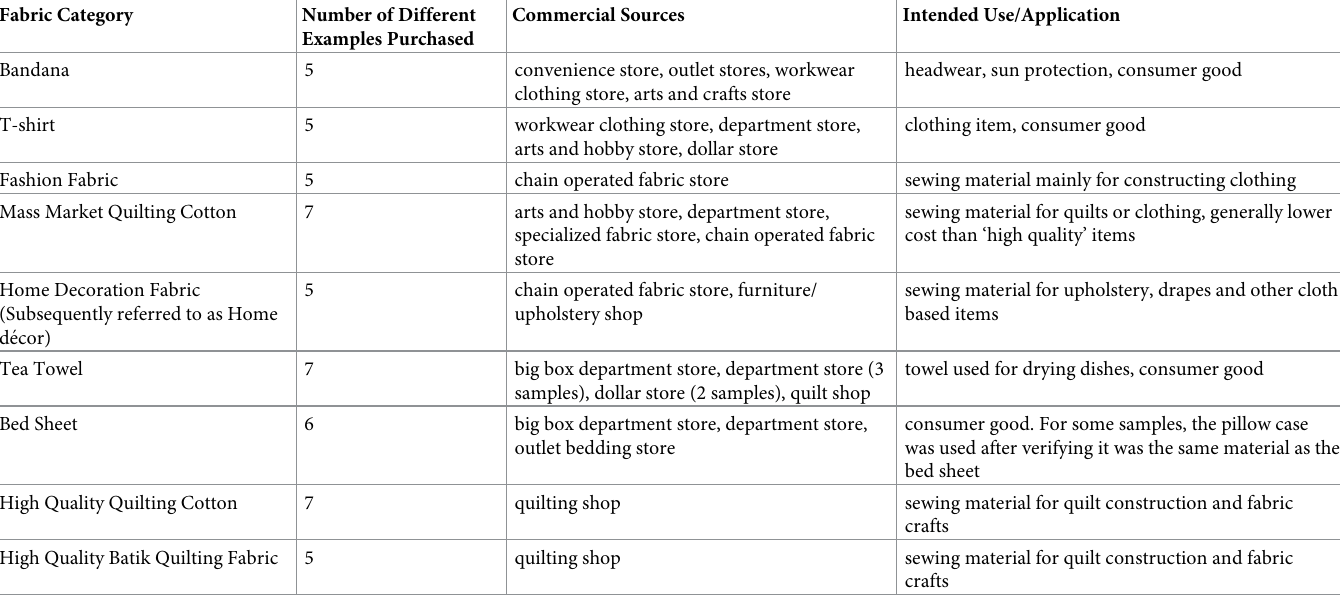
Table 1. Consumer fabric categories, purchase source and intended fabric application of items characterized. Fabric